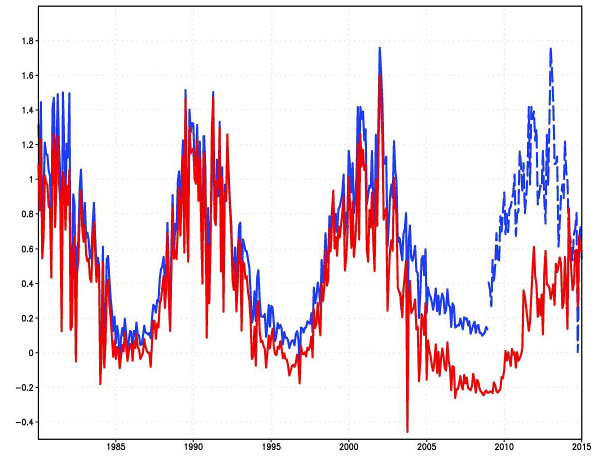
Figure 2. Monthly mean TSI anomaly (Wm − 2 ) with respect to 1882–1931 recommended for CMIP5 (blue; dashed line after year 2008 is the repetition of the data for 1998–2008) and for CMIP6 (red).